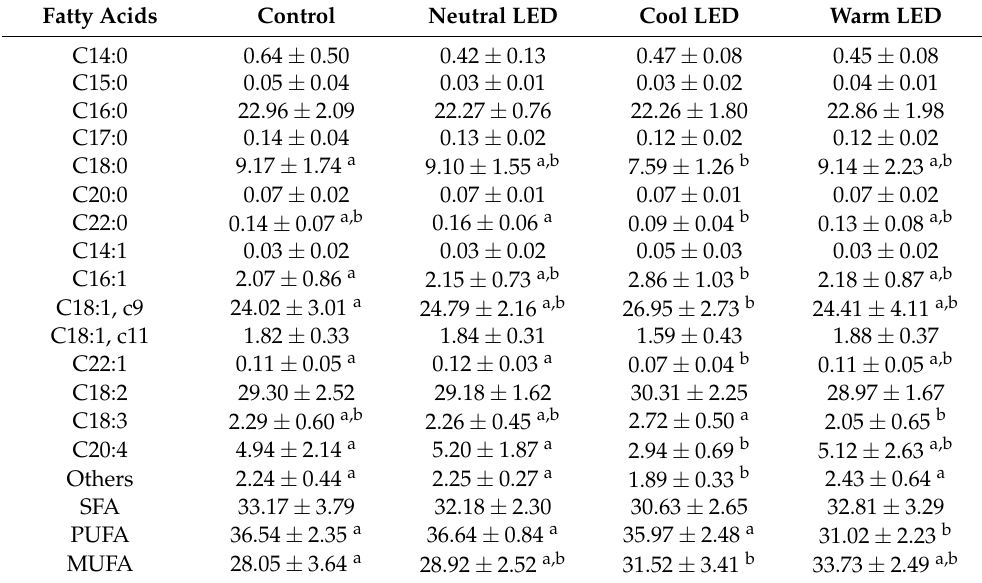
Table 2. Fatty acid profiles (%) of breast meat samples from red chickens exposed to different light